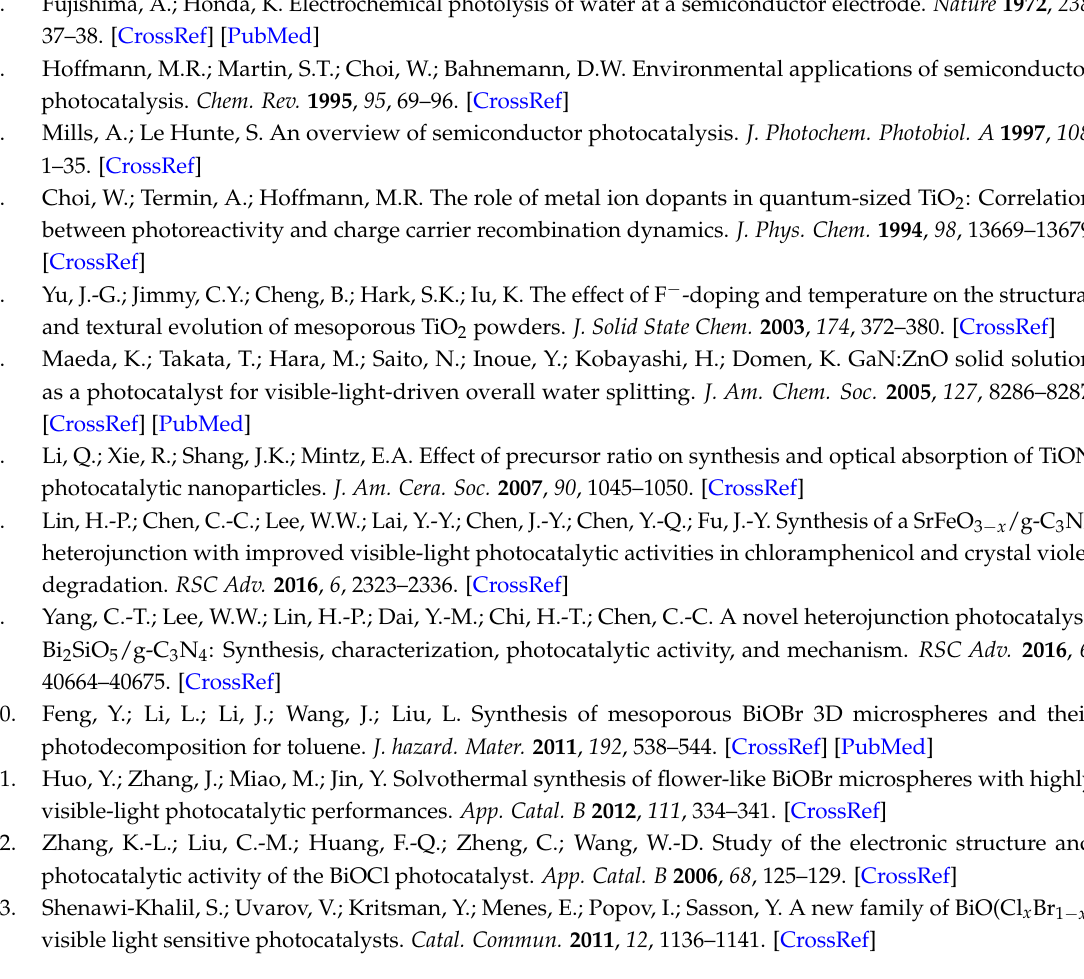
Figure S1: The comparison of total and partial density of states of BiOI by different density functional theory (DFT) methods. Figure S2: The imaginary part and the real part of the dielectric functions of BiOI along two polarization direction and polycrystalline model by generalized-gradient approximation (GGA) method. Figure S3: The imaginary part and the real part of the dielectric functions of BiOI along two polarization direction and polycrystalline model by on-site Coulomb interactions (GGA + U)